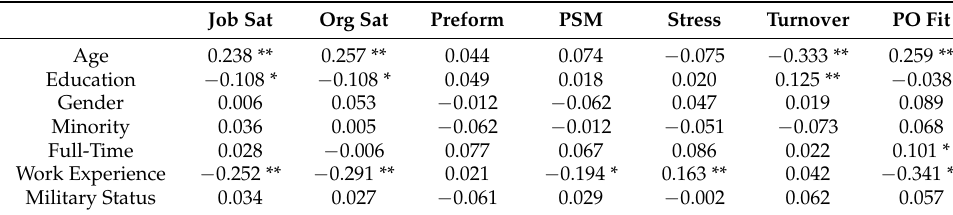
Table 5. Control variables and military status regressed on study variables. Job Sat Org Sat Preform PSM